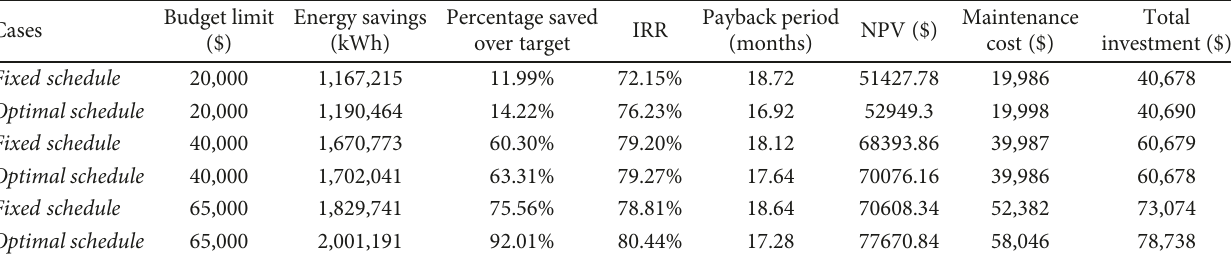
Table 3: Performances of maintenance plans with di ff erent budget limits.